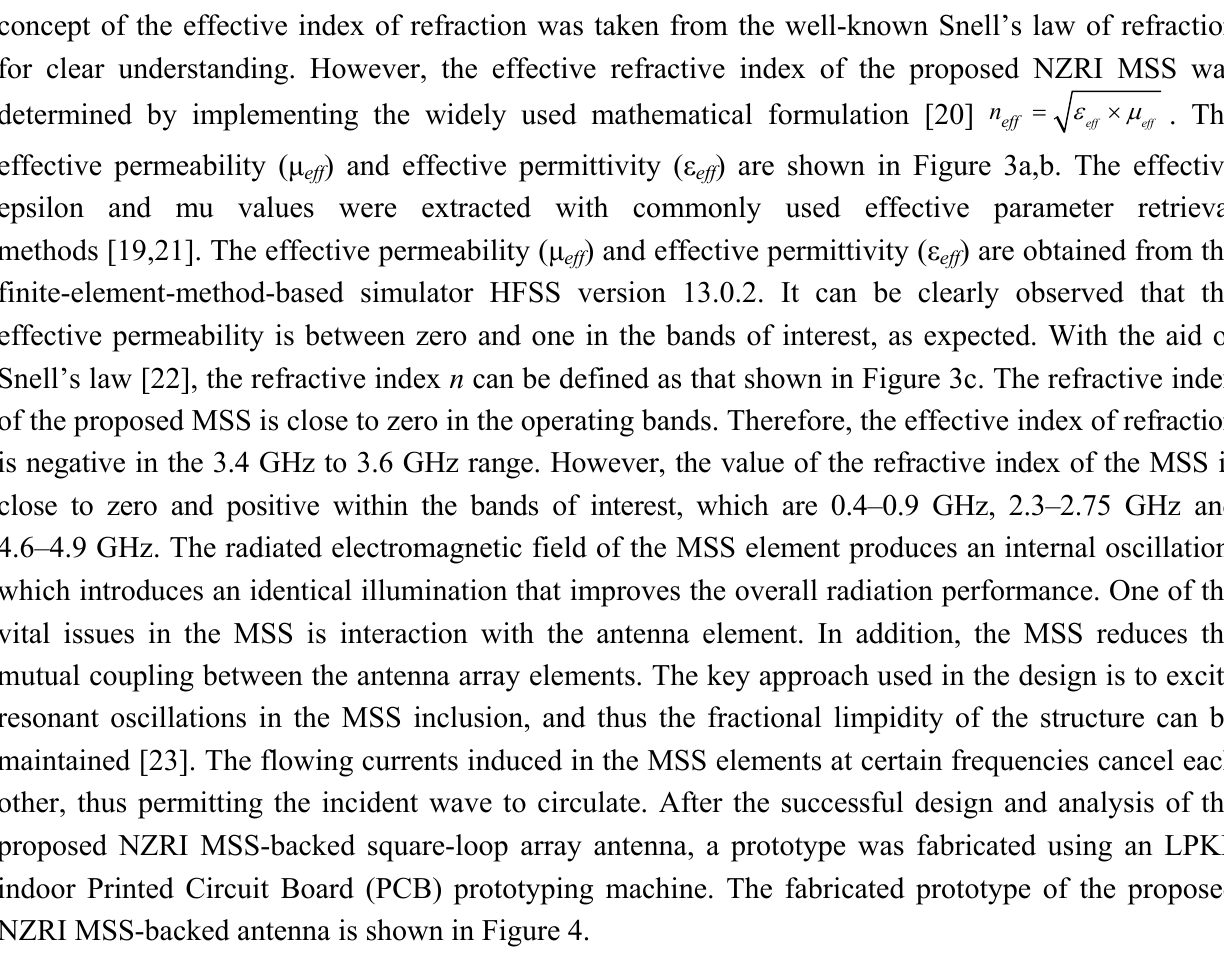
Figure 1. Design schematic of ( a ) the array element; ( b ) the meta-surface structure (MSS) element of the proposed